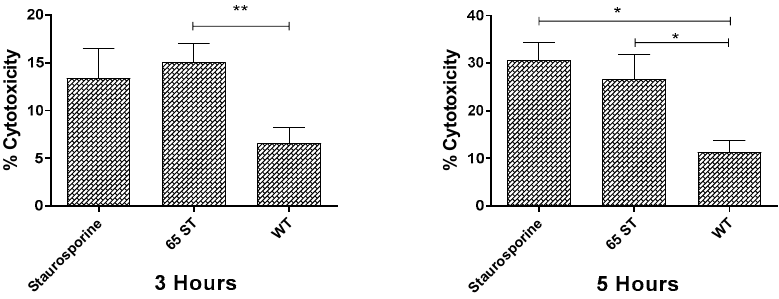
Figure 6. Release of LDH by HKDM infected with WT E. ictaluri and the 65ST T3SS mutant for 3 and 5 h post-infection level of cytotoxicity was significantly lower for the WT than for the staurosporine treated cells or the 65ST infected cells at both 3 and 5 h post-infection. (* = p ≤ 0.1, ** = p ≤ 0.01)